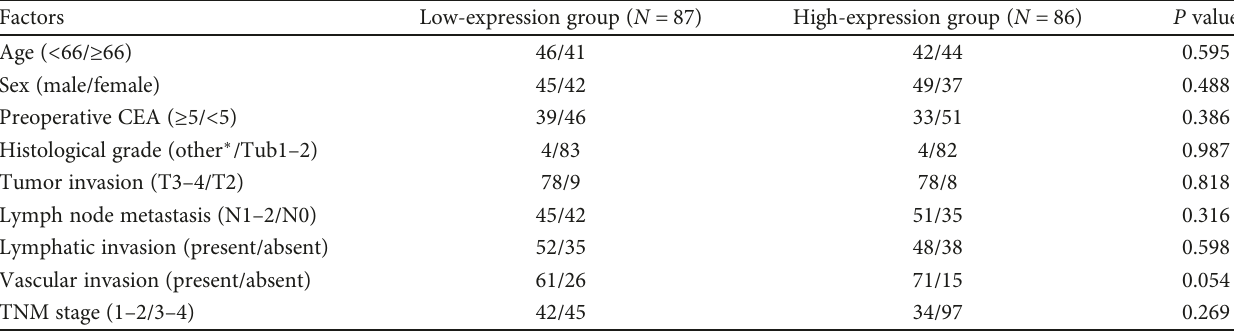
Table 2: Patient characteristics according to Oct4 mRNA expression.